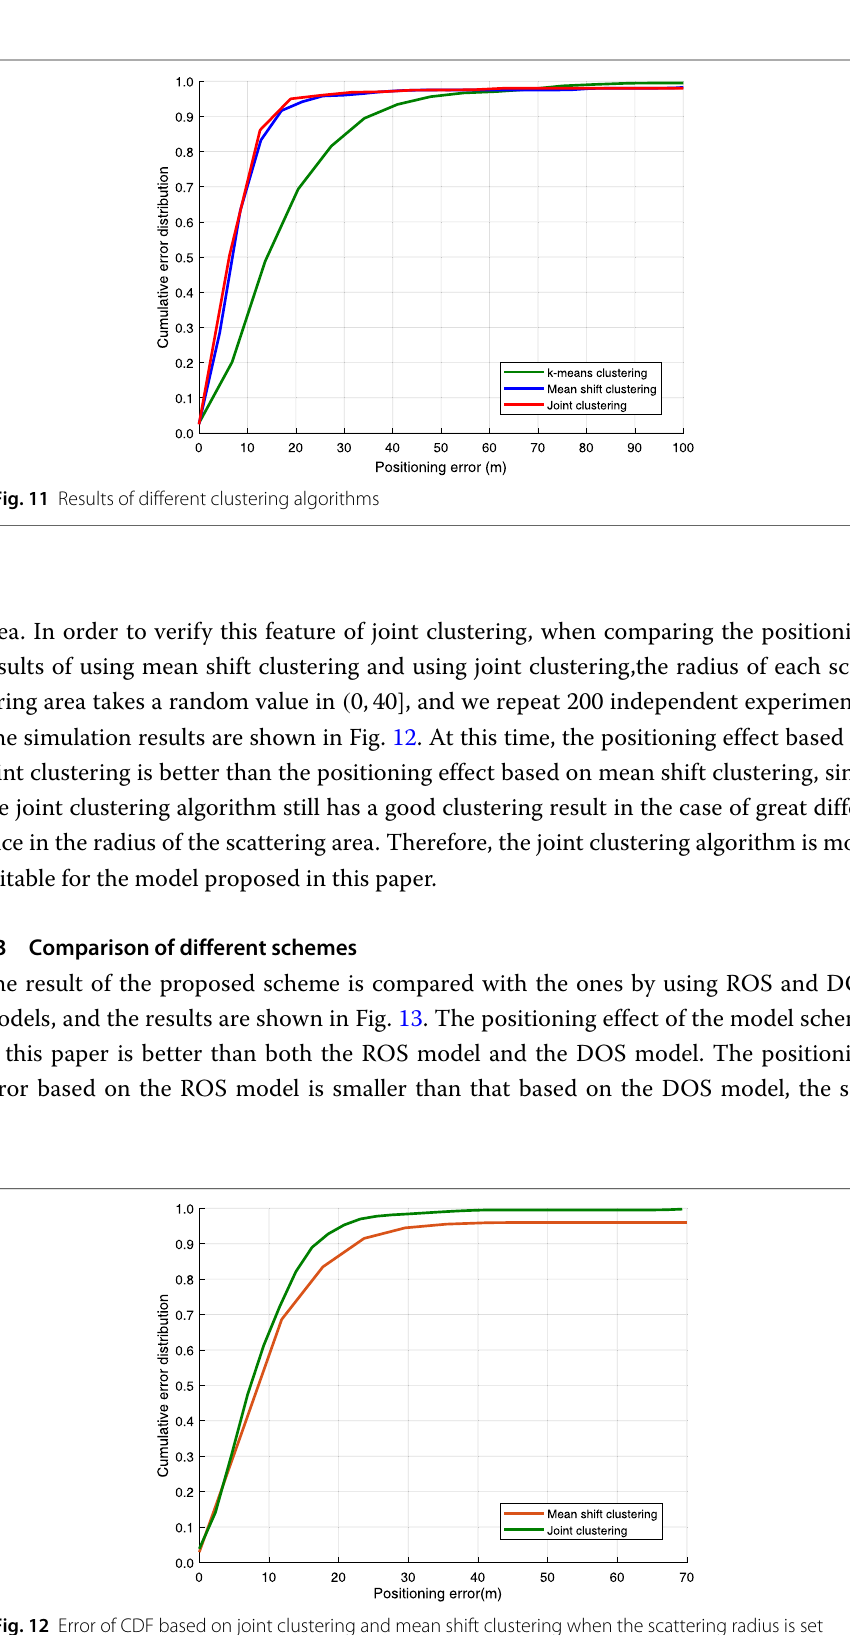
Fig. 12 Error of CDF based on joint clustering and mean shift clustering when the scattering radius is set